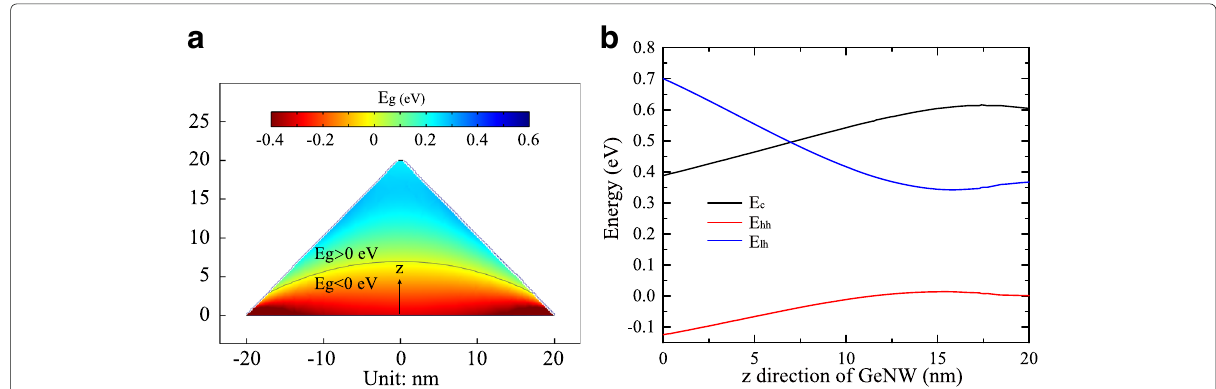
Fig. 6 a The strain-dependent bandgap in the GeNW distributed by positions. b The strain-dependent band edge energies along z direction in the